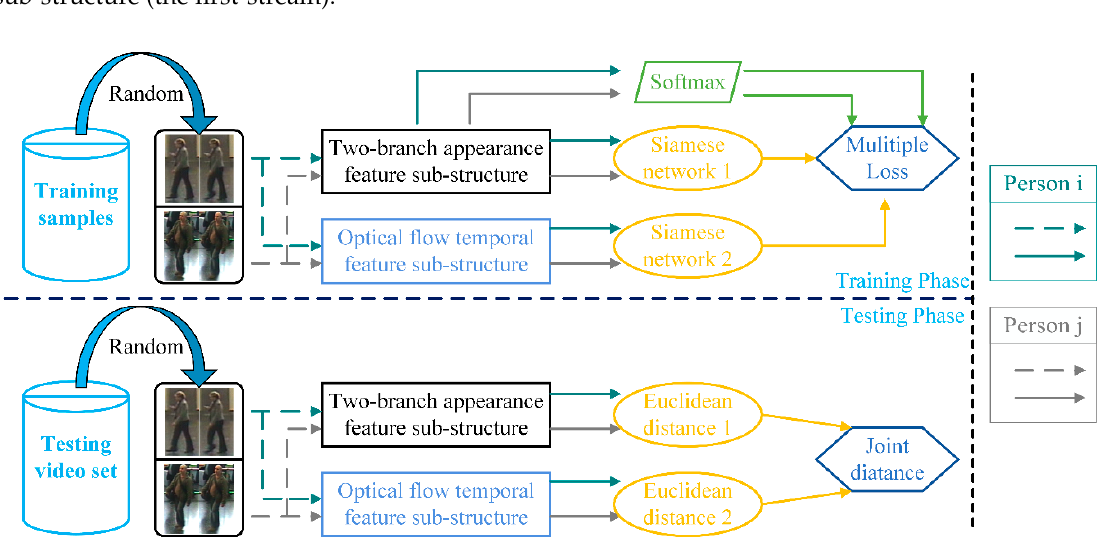
Figure 6. The training steps and test steps of the proposed hybrid end-to-end deep learning architecture. The upper left side of the figure is the training phase, and the lower-left side is the test phase. The right side of the figure is an annotation of the arrows of different colors.